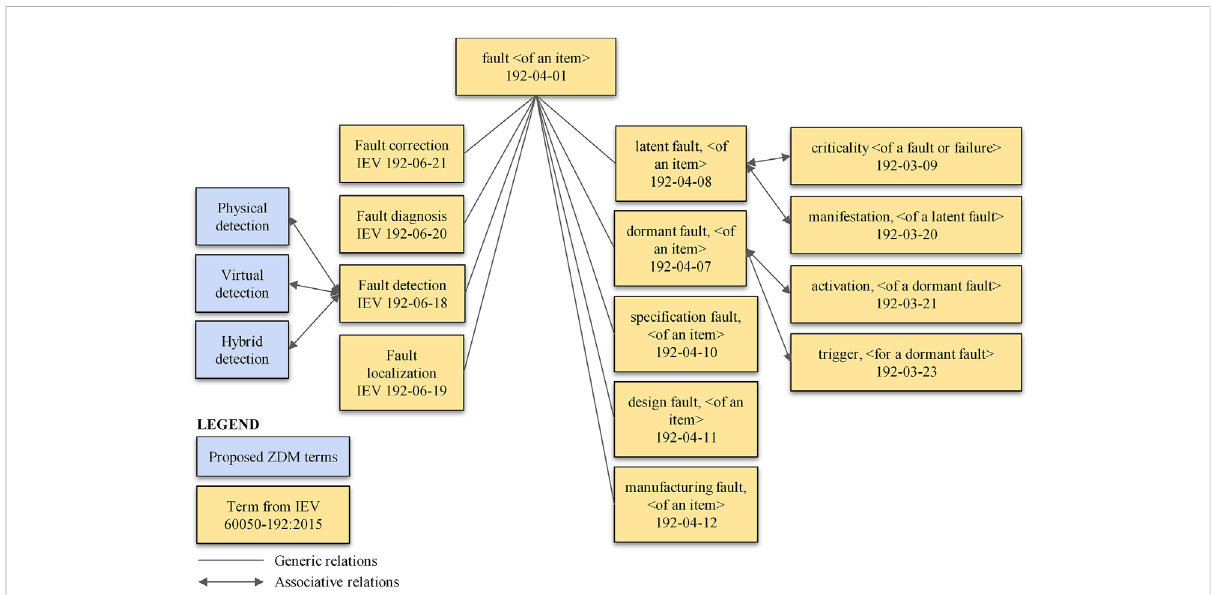
FIGURE 6 Some concepts related to fault in IEV 60500 – 192:2015 and relation to ZDM terms. Terms collected from the IEV include the entry number in that standard for better reference and traceability.